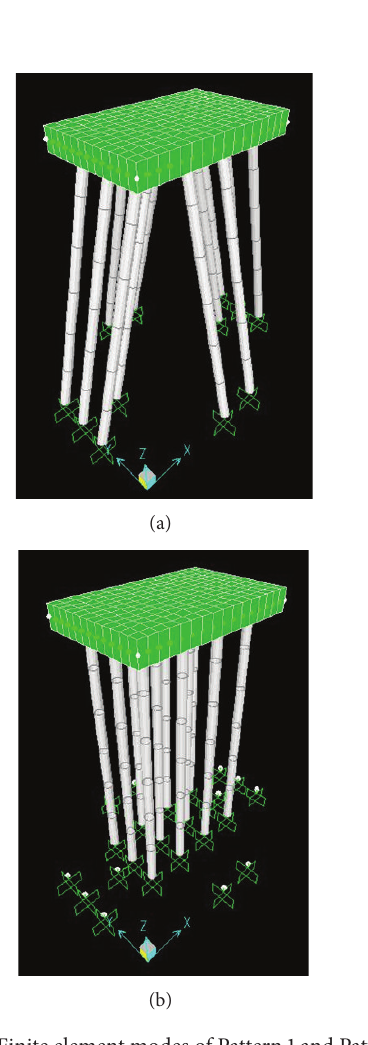
Figure 5: Finite element modes of Pattern 1 and Pattern 2.